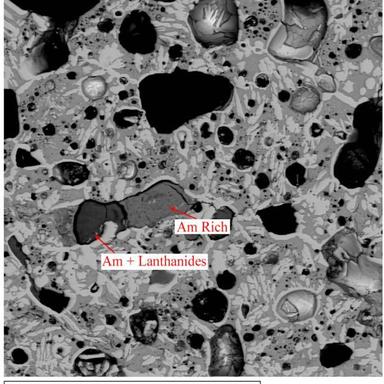
High magnification detail of the intermediate region microstructure, region 2 in